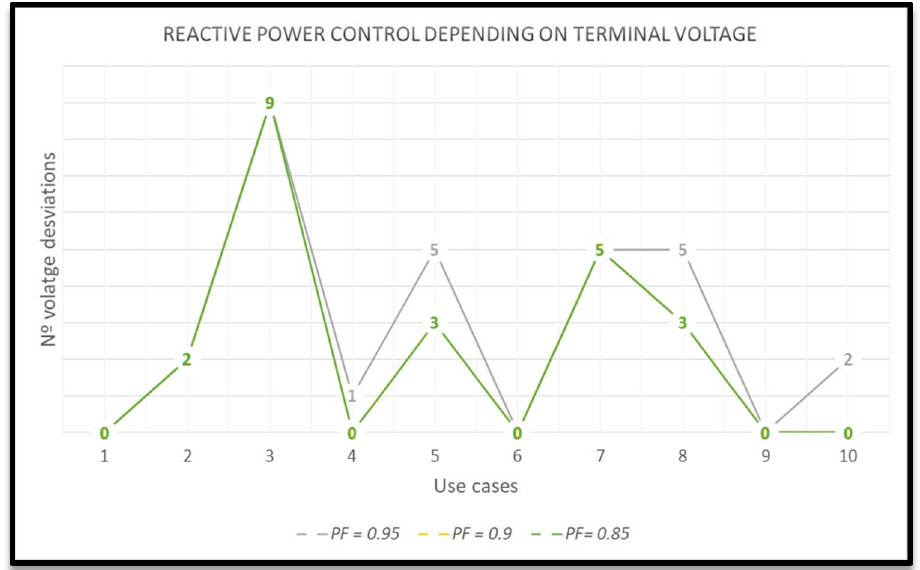
Figure 13. Reactive power control depending on terminal voltage: Voltage deviations (More information see Table A10 in Appendix C).